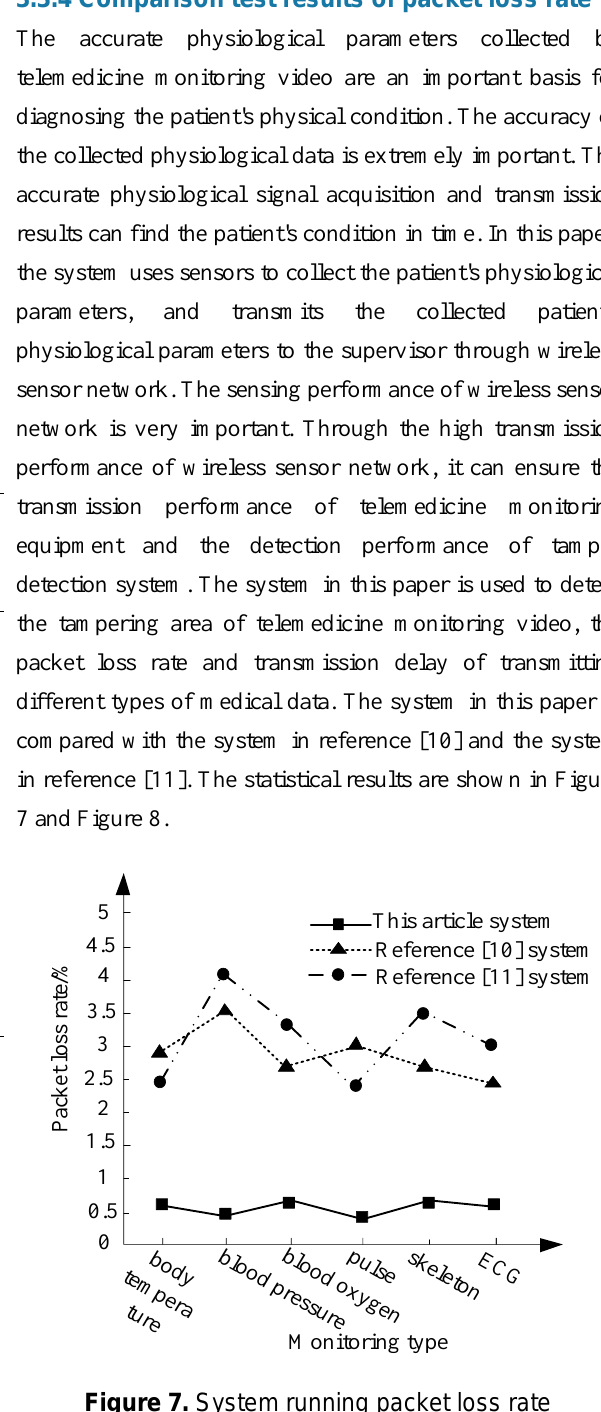
Figure 7. System running packet loss